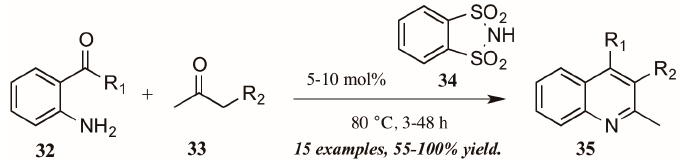
Figure 16. Brønsted acid-mediated Friedländer quinoline synthesis.